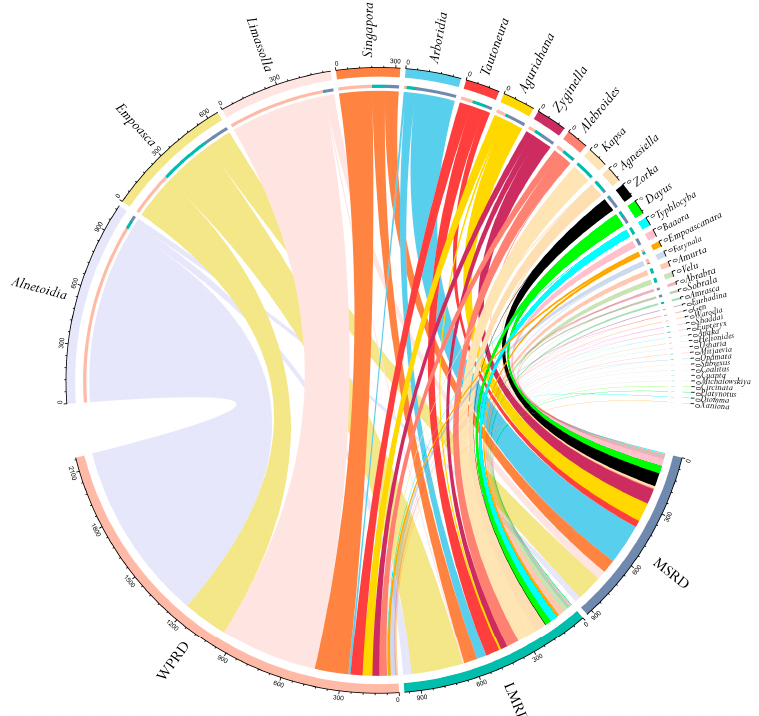
Figure 4. A chord diagram depicting the amount of typhlocybine leafhoppers in different stages of rocky desertification. Note: the thickness of the color and lines expresses the connection and strength of different types of leafhoppers and stone desertification. MSRD: moderate–severe rocky desertification; LMRD: light–moderate rocky desertification; WPRD: without-potential rocky desertification.